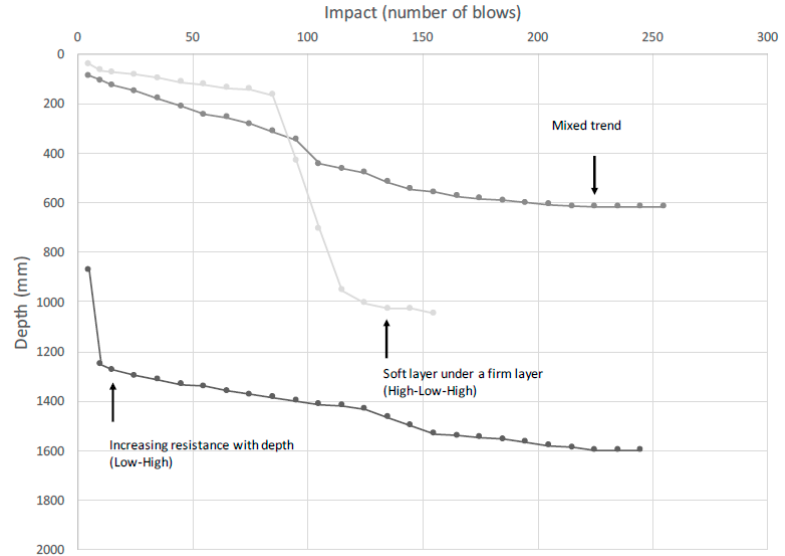
Figure 2. Representative sludge strength with depth classification based on method from Seal [7].